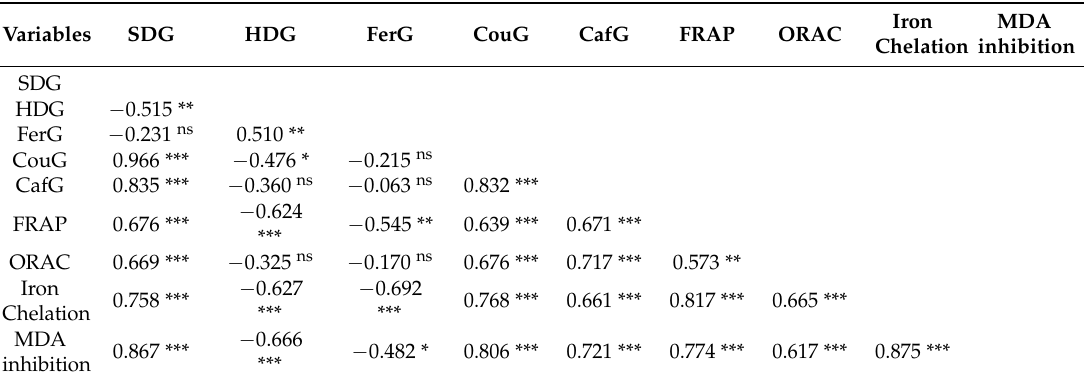
Table 2. Correlation analysis using Pearson correlation coefficient